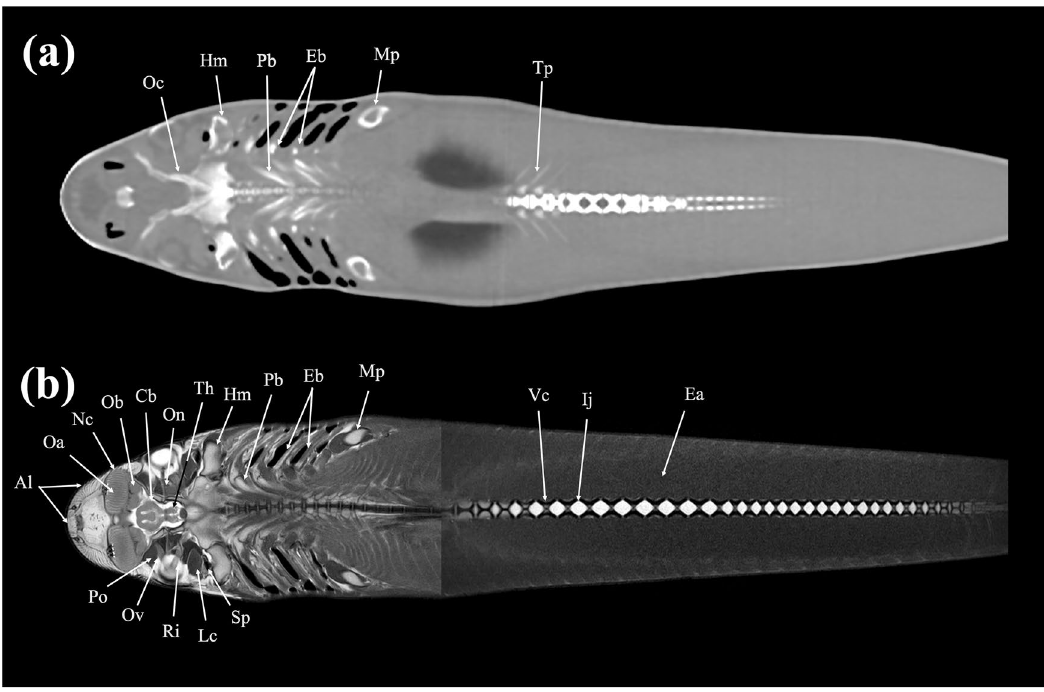
Figure 20. Dorsal ( a ) CT and ( b ) MR images of a banded houndshark ( Triakis scyllium ) at level 20 of Fig. 25. Al Ampullae of Lorenzini, Cb Cerebrum, Ea Epaxial, Eb Epibranchial, Hm Hyomandibular, Ij Intervertebral joint, Lc Levator cranium maxillae, Mp Metapterygium, Nc Nasal capsule, Oa Olfactory lamellae, Ob Olfactory bulb, Oc Optic capsule, On Optic nerve, Ov Obliquus ventralis, Pb Pharyngobranchial, Po Preorbitalis, Ri Rectus inferior, Sp Spiracle, Th Thalamus, Vc Vertebral centrum.